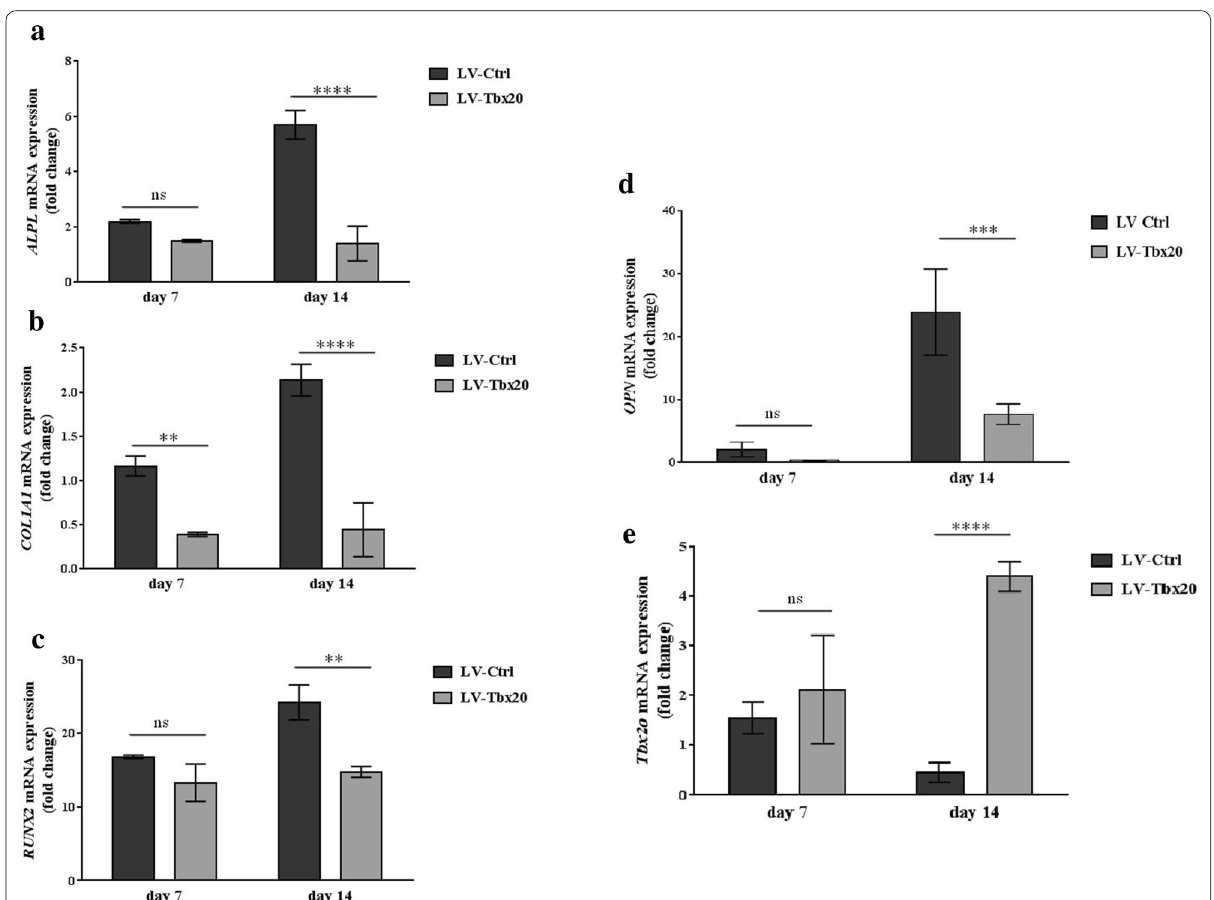
Fig. 5 Analysis, by RT‑qPCR, of the expression of the osteoblast marker genes ALPL ( a ), COL1A1 ( b ), RUNX2 ( c ), OPN ( d ), and human Tbx20 ( e ) in LV‑Ctrl‑ and LV‑Tbx20‑transduced Ad‑MSCs that were maintained in osteogenic differentiation medium for 7 or 14 days. Expression levels were normalized to those in untreated cells (i.e. cells cultured in normal growth medium) as mean **** p < 0.0001. *** p < 0.001. ** p < 0.01. ns not significant. Experiments were performed in triplicate and repeated three